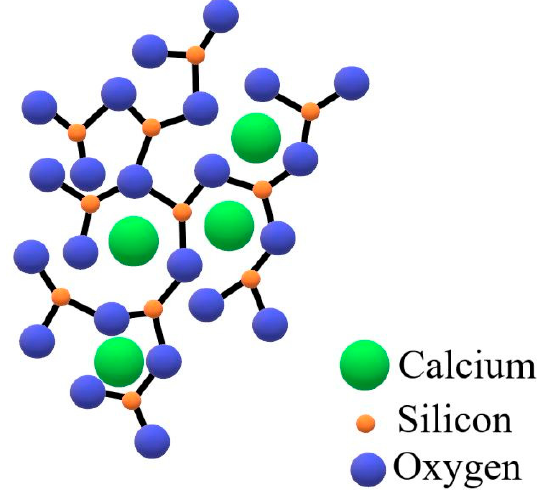
Figure 17. Structure of CaO-SiO 2 liquid slag